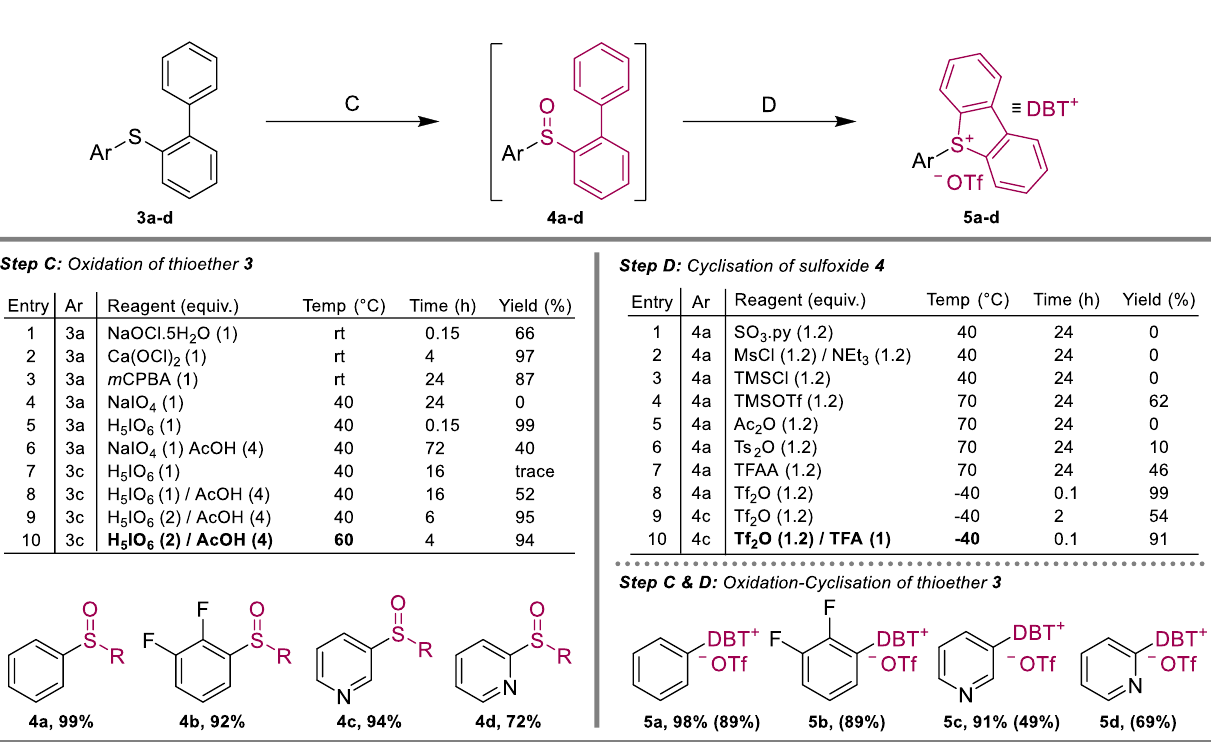
Scheme 4. Optimisation of the reaction conditions for one-pot oxidation (Step C)-cyclisation